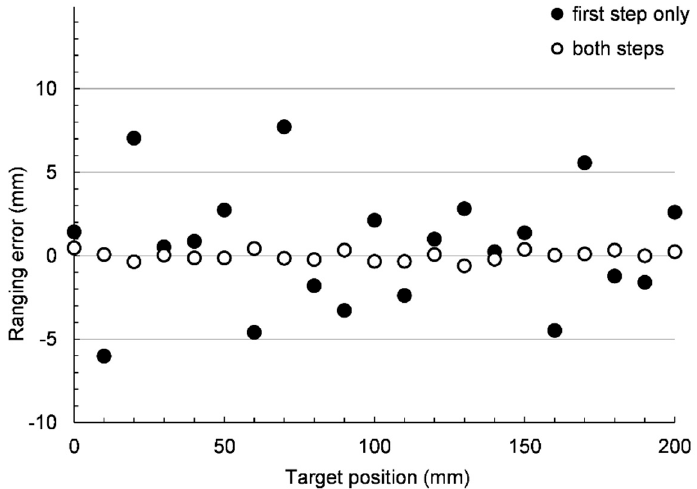
Figure 6. Errors in the distance measurement. The largest deviation after the first step is +7.7 mm (at position 70 mm); after the second step the largest deviation is − 0.61 mm (at a position of 130 mm).